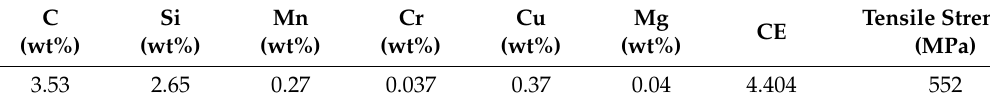
Figure 6. Top and bottom view of the part geometry.